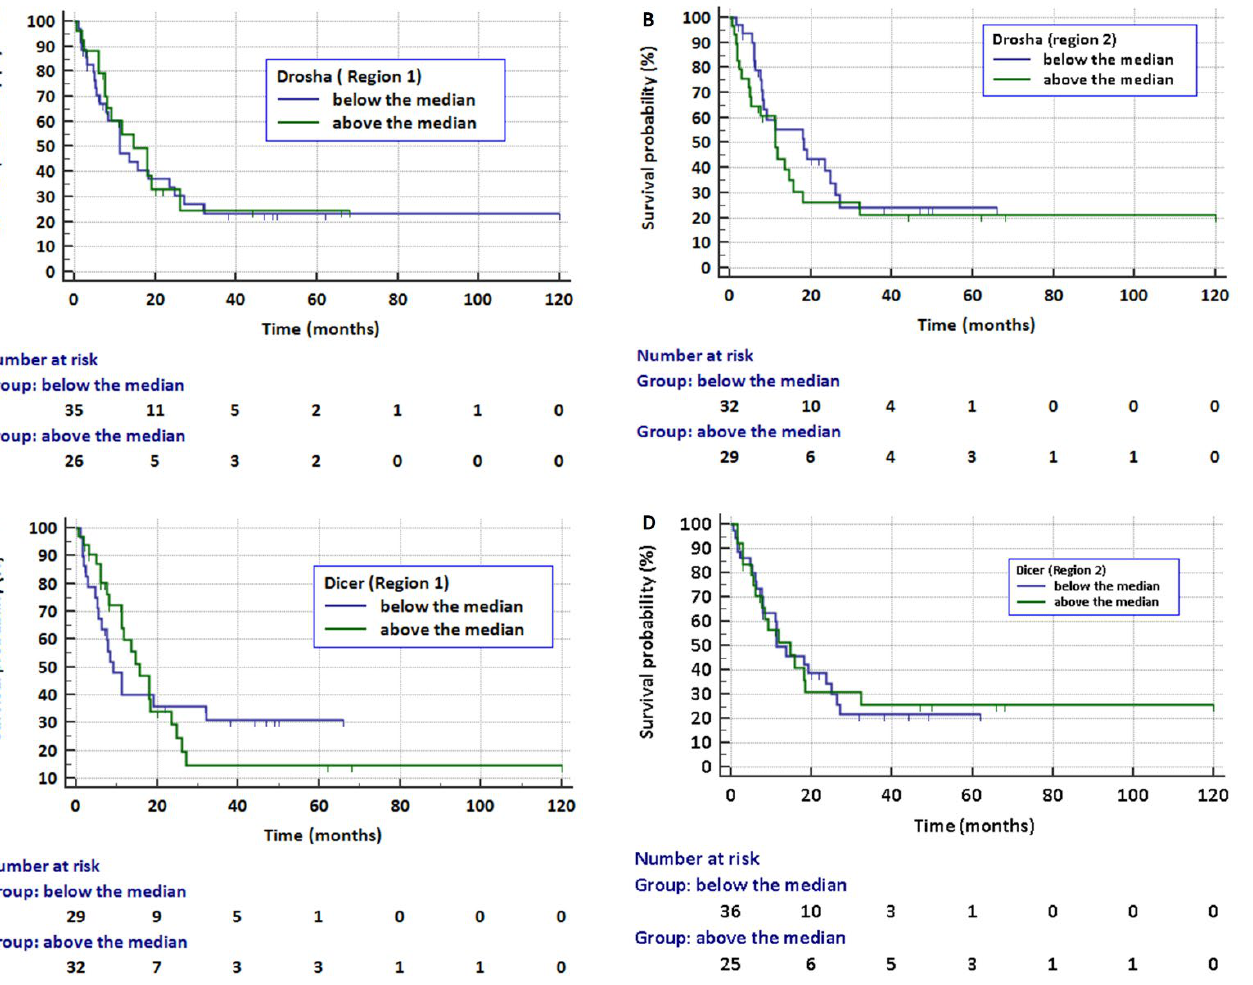
Figure 5. Kaplan–Meier curves representing overall survival according to the methylation level of DROSHA ( A , B ) and DICER ( C , D ) (description in the text).